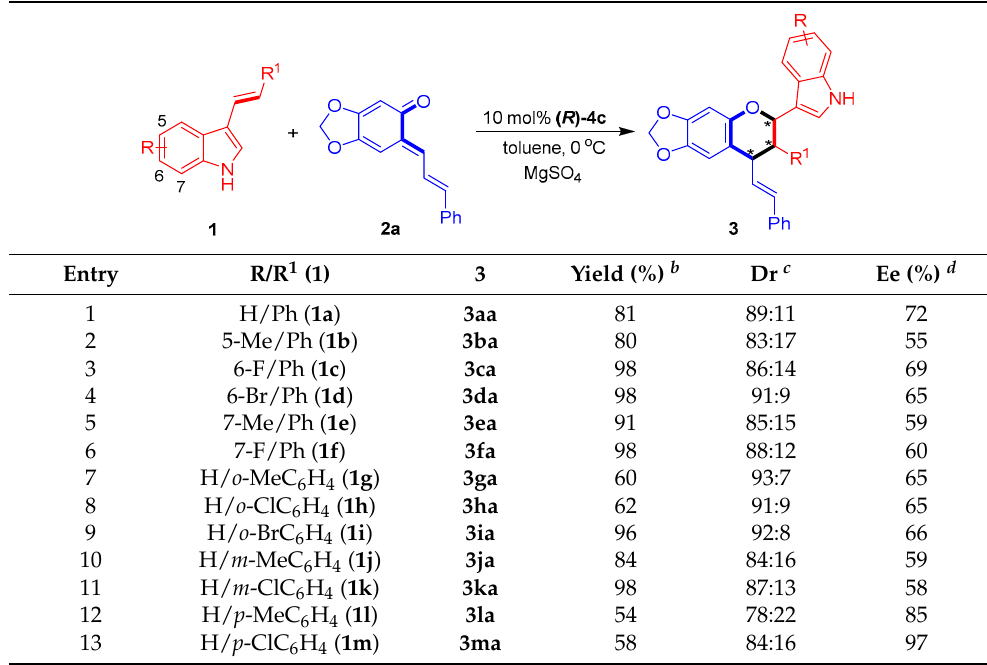
Table 3. Substrate scope of 3-vinylindoles 1 a .